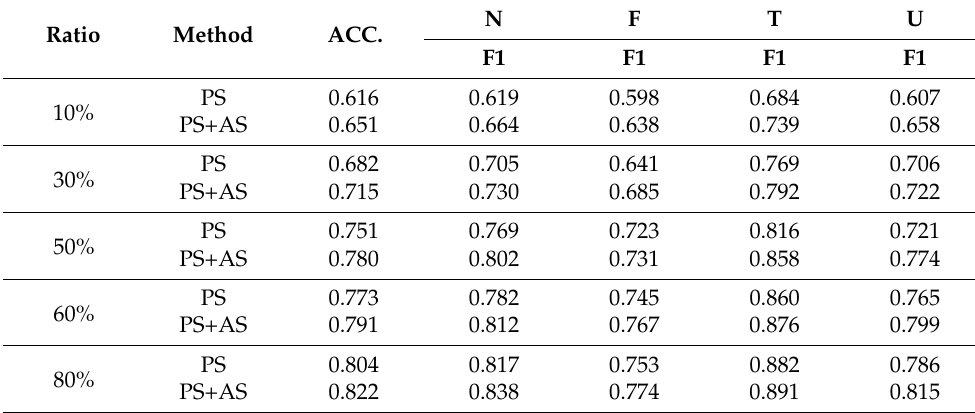
Figure 7. Comparison of the early and complete propagation structures of rumors. Table 6. Early detection results of rumors on Twitter15.